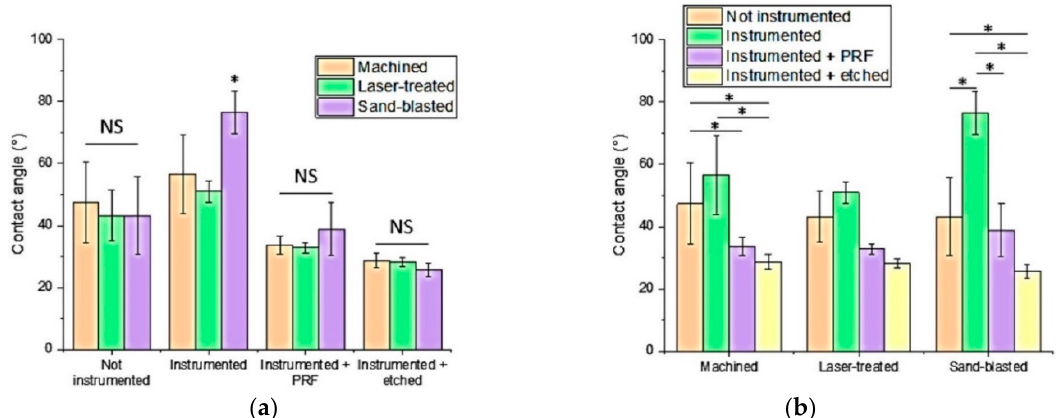
Figure 3. ( a ) Histogram comparing the three implant surfaces. No significant difference was found between machined, laser-treated, and sandblasted surfaces within brand new, platelet-rich fibrin (PRF), and etched groups. A statistically significant difference was found within the instrumented group between sandblasted and machined and between sandblasted and laser-treated surfaces. ( b ) Histogram comparing the four experiment steps. No significant difference was found within the laser-treated surface. Significant differences were found within machined surfaces (between brand new and etched, instrumented and etched, instrumented and PRF groups) and sandblasted surfaces (between brand new and instrumented, brand new and etched, instrumented and PRF, instrumented and etched groups). Statistically significant differences between samples are reported with an asterisk (*, p < 0.05); NS: Not significant.”